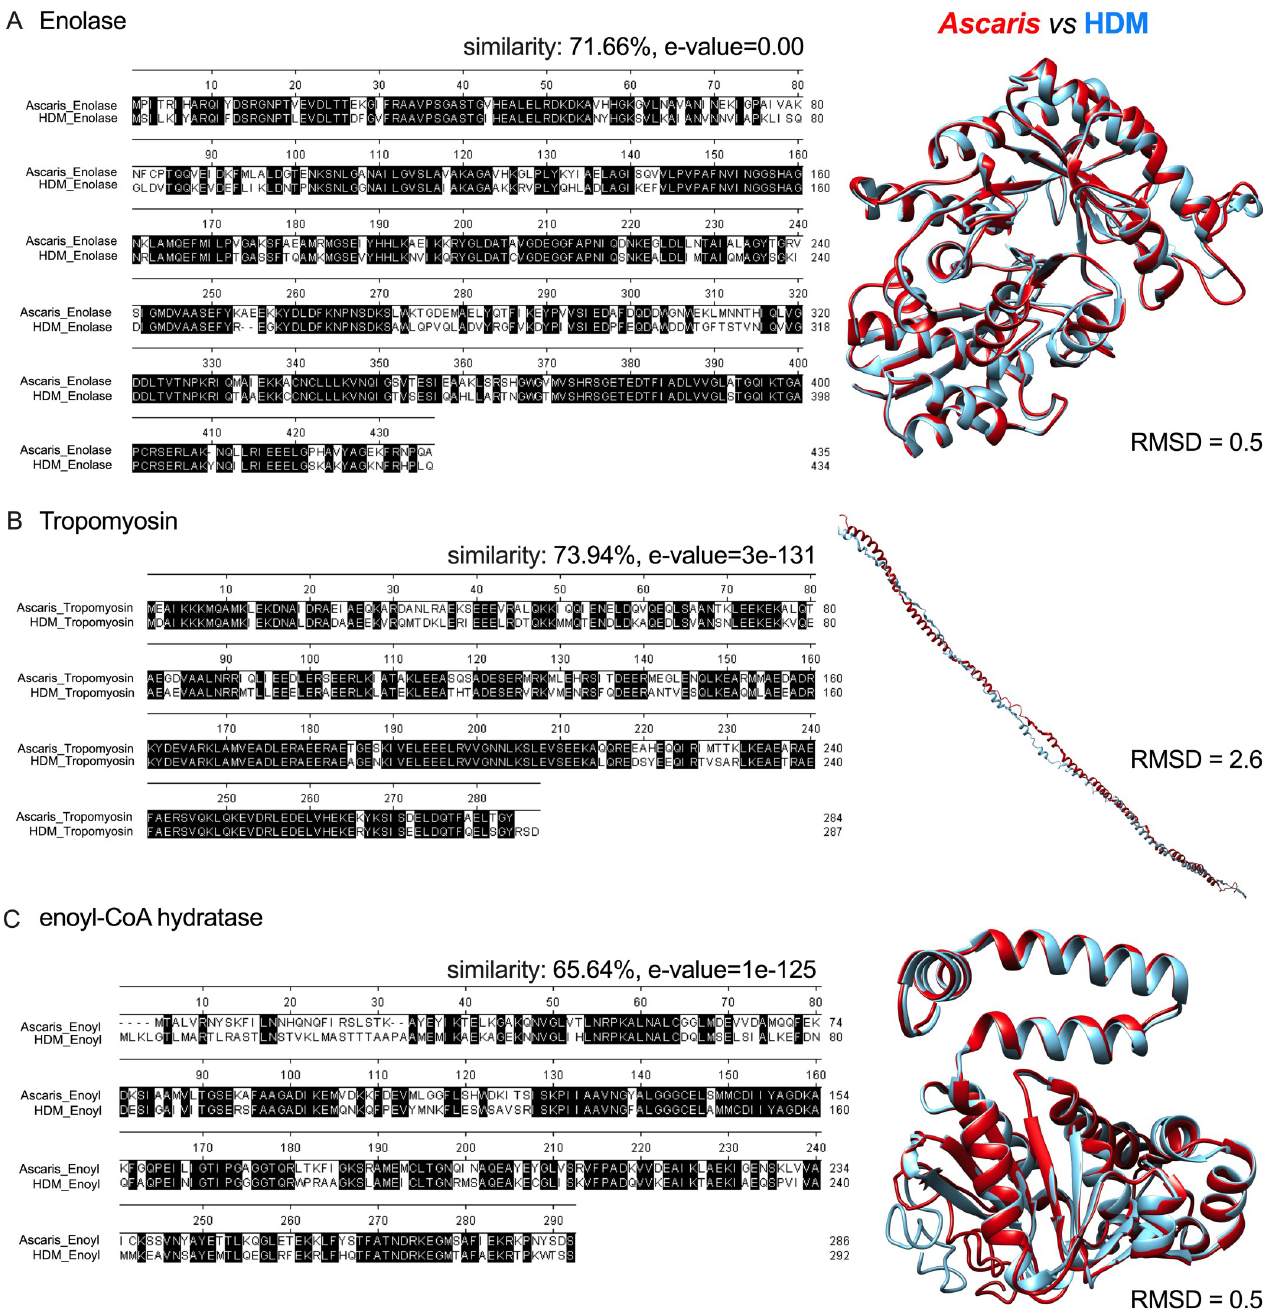
Fig 4. Protein sequences of the antigenic targets from lung-stage Ascaris larvae that cross-react with HDM-driven antibodies and their molecular and structural level of similarity with HDM homolog proteins. Alignment of Ascaris and HDM enolase (A), tropomyosin (B) and enoyl-CoA hydratase (C) sequences showing identical (shaded in black) amino acids and predicted 2D structure for Ascaris (red) and HDM (blue).